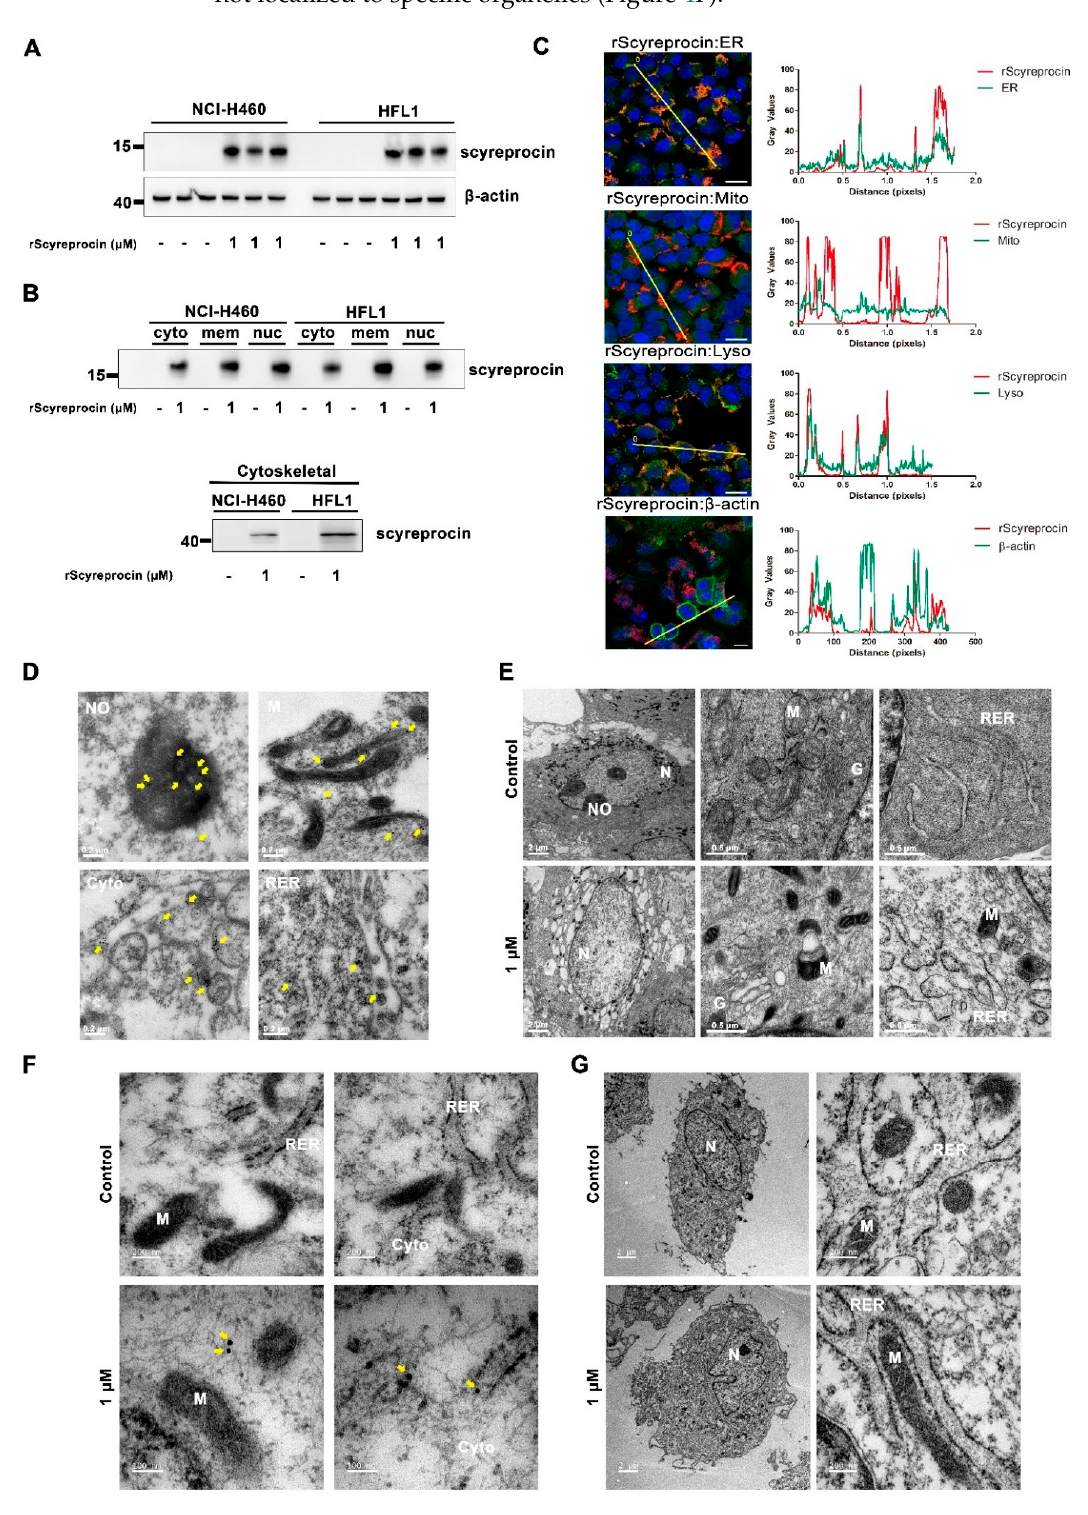
Figure 4. Recombinant scyreprocin (rScyreprocin) penetrated cell membrane and targeted and damaged organelles of H460 cells. ( A ) Detection of rScyreprocin penetrated into H460 and